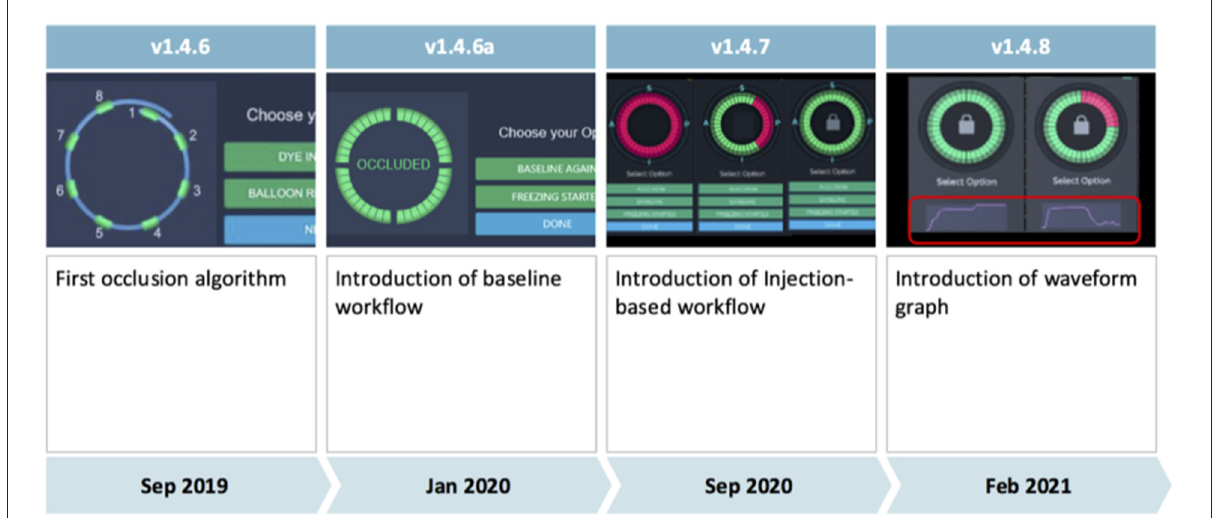
FIGURE1 Evolution of the KODEX-EPD occlusion tool from software version 1.4.6 to software version 1.4.8. The injection-based workflow assesses injected contrast dye or saline along the acquiring circular mapping catheter and was used in all patients since release of software version 1.4.7.